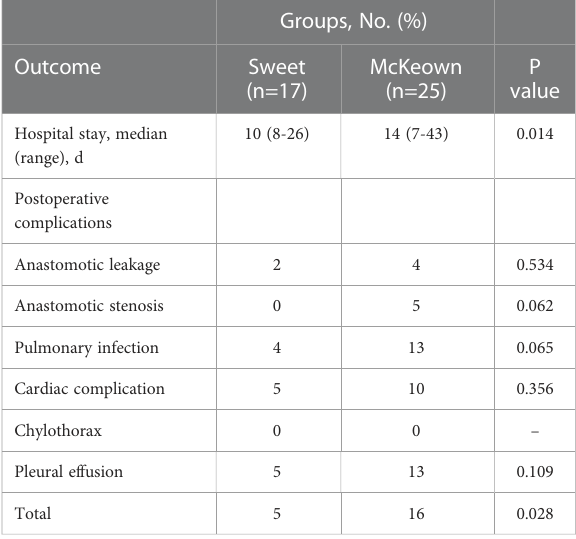
TABLE 4 Postoperative Outcomes in patients over 70 years old. Groups, No. (%)